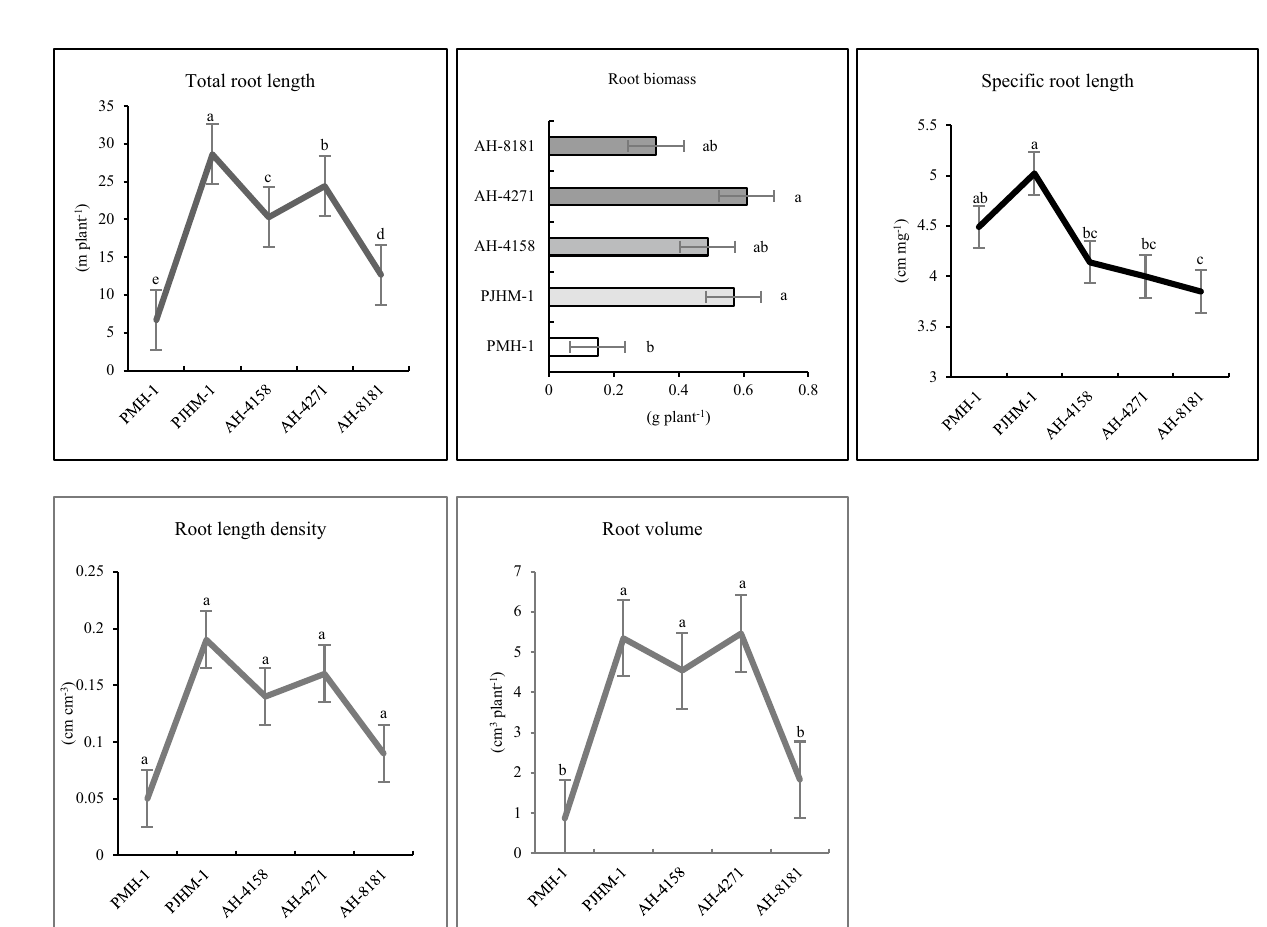
Table 7. Initial soil chemical properties of the experimental